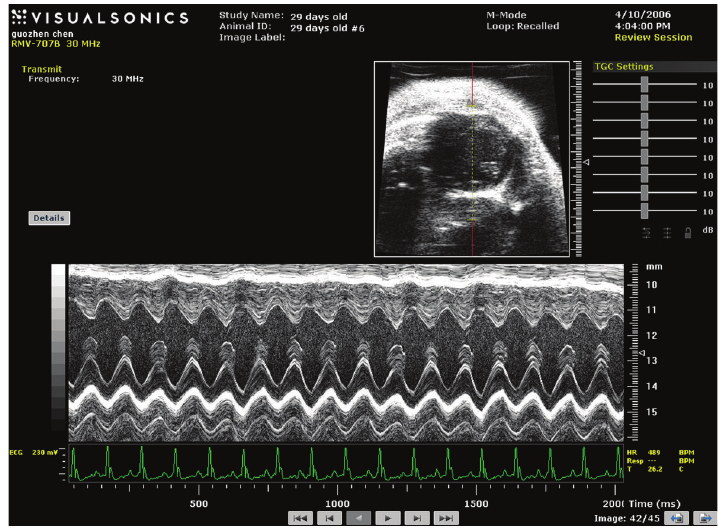
Figure 1: M-mode imaging obtained on a wild type mouse using a 30-MHz transducer.